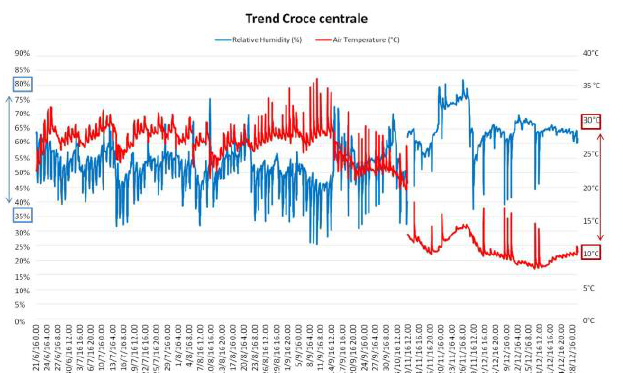
Figure 6. Air Temperature and Relative Humidity Trends, Room (1) Croce